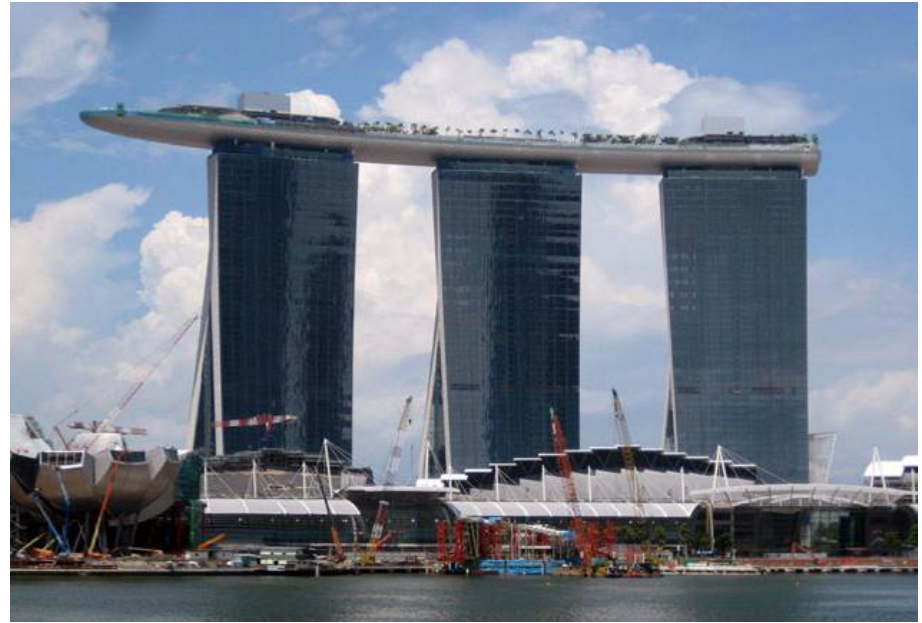
Figure 14. Marina Bay Sands (courtesy of Philip Oldfield, Council on Tall Buildings and Urban